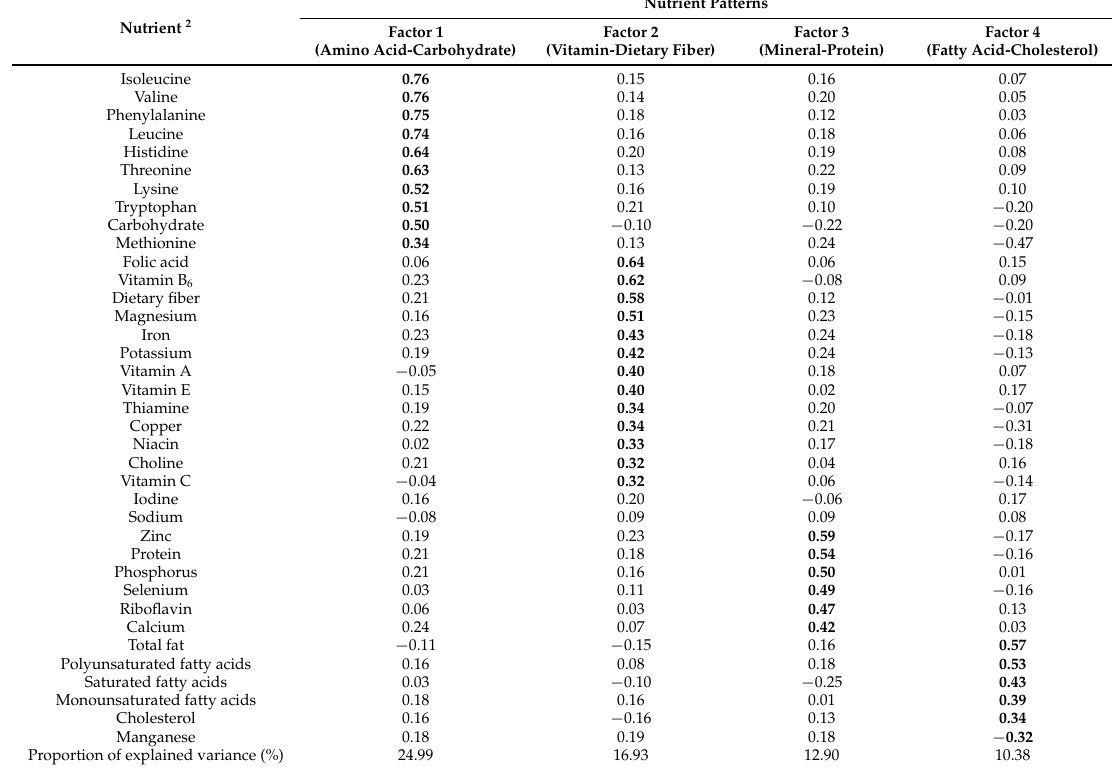
1 : Dietary patterns were determined by factor analysis; 2 : The factor-loading scores with absolute values of ě 0.30 are